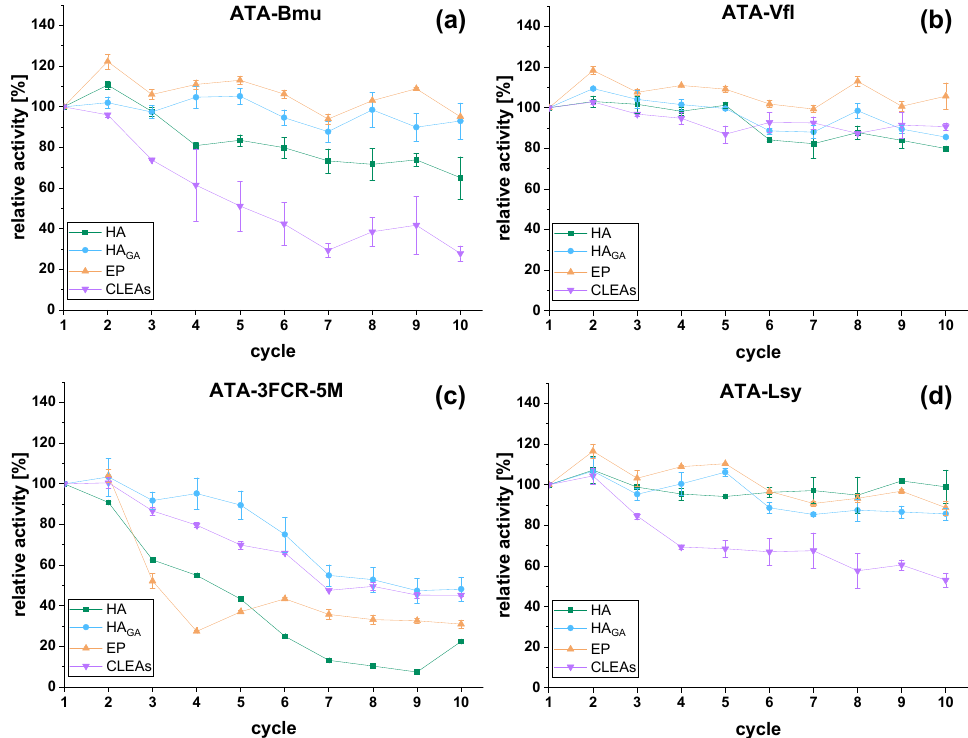
Figure 3. Recycling stability of different transaminase immobilizates. Various immobilizates of different transaminases ( a ) ATA-Bmu, ( b ) ATA-Vfl, ( c ) ATA-3FCR-5M, and ( d ) ATA-Lsy) were used in repeated kinetic resolutions of rac -1-PEA (2.5 mM) at 37 °C for 45 min each (50 mM Tris pH 8.0, 0.5% DMSO, 0.1 mM PLP, and 2.5 mM pyruvate). After each cycle, the supernatant was taken, the conversion was determined spectrophotometrically, and the immobilizates were washed (3 times with 50 mM Tris pH 8.0, 0.1 mM PLP), before fresh reaction solution was added. The initial activity of cycle 1 was set as 100%. All recycling studies were performed in duplicates, and the error bars of each average data point represent the minimum and maximum values.